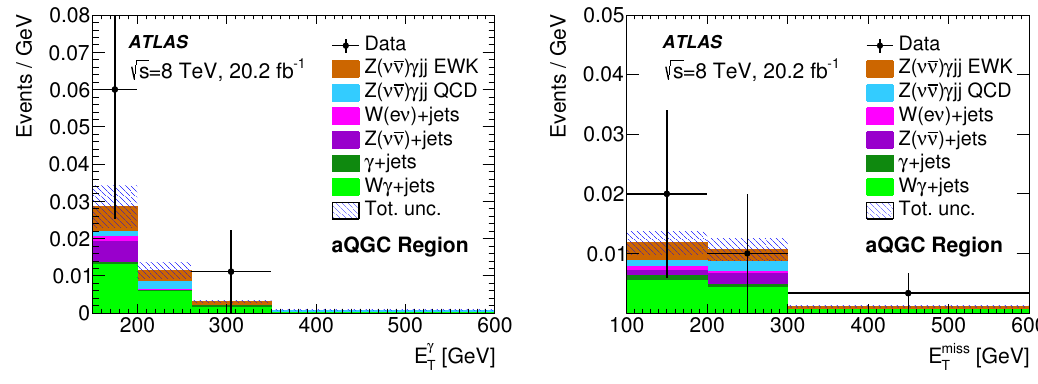
Figure 6 . Distributions of the photon transverse energy E (cid:13) (left) and E miss (right) for the neutrino T T channel in the aQGC region with E (cid:13) (cid:21) 150 GeV for the data (black points), and for the signal T process and various background components (coloured templates). The hatched blue band shows the systematic and statistical uncertainty added in quadrature (\Tot. unc.") in the signal and background prediction, while the error bars on the data points represent the statistical uncertainty of the data set. The number of events in each bin is divided by the bin width. The last bin also includes events beyond the range